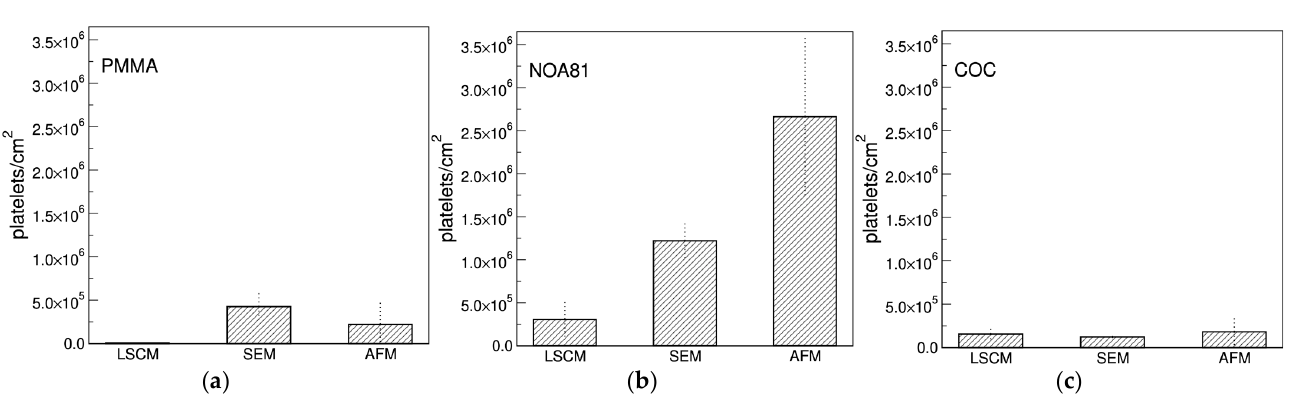
Figure 7. Comparison among platelets density per unit area measured with the different imaging techniques. In ( a ) platelets adherent to PMMA are shown, in ( b ) to NOA81 and in ( c ) to the COC polymer.